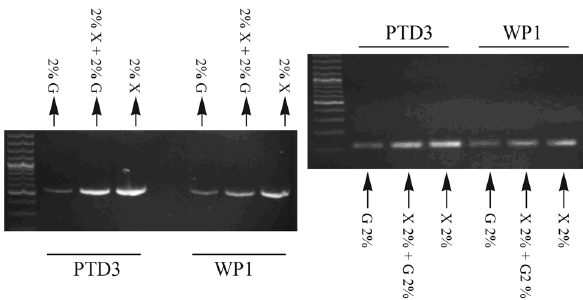
Figure5 -WP1andPTD3XR/XDHgene-expressionincellsgrownin2% glucose, 2% xylose and 2% glucose+2% xylose. RNA templates used un- der different conditions are labeled in the